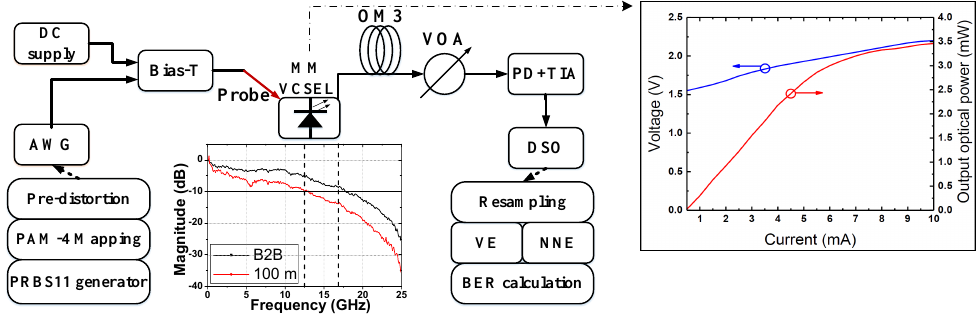
Figure 2. Experimental